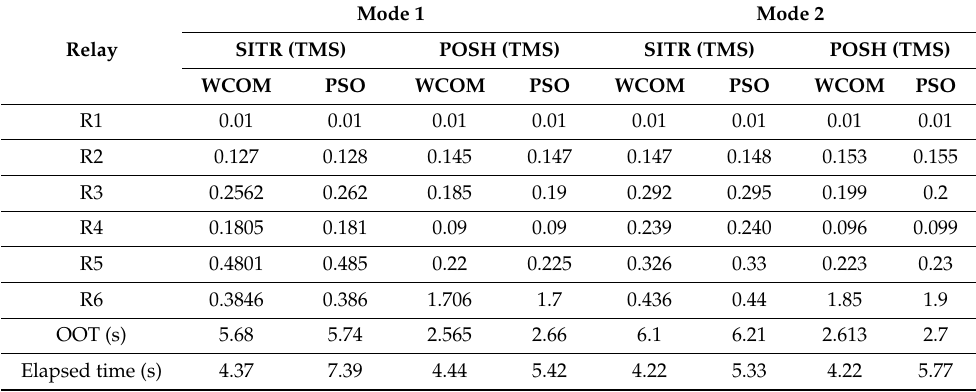
Figure 7. Convergence curves of the proposed WCOM and PSO optimization algorithms for ( a ) SITR, Mode 1; ( b ) POSH, Mode 1; ( c ) SITR, Mode 2; ( d ) POSH, Mode 2. Table 8. The results of WCOM and PSO algorithms in OOT and elapsed time in Mode 1 and